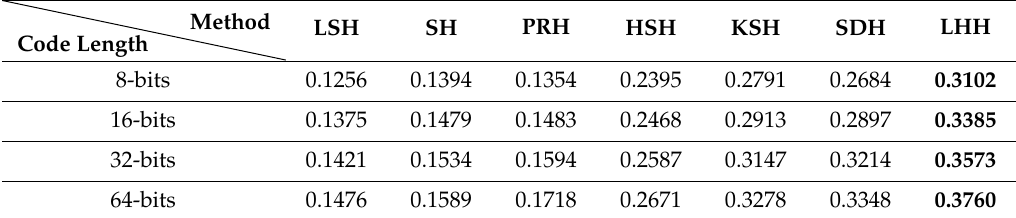
Table 3. Comparison of mAP with di ff erent hash code lengths on UCMD.